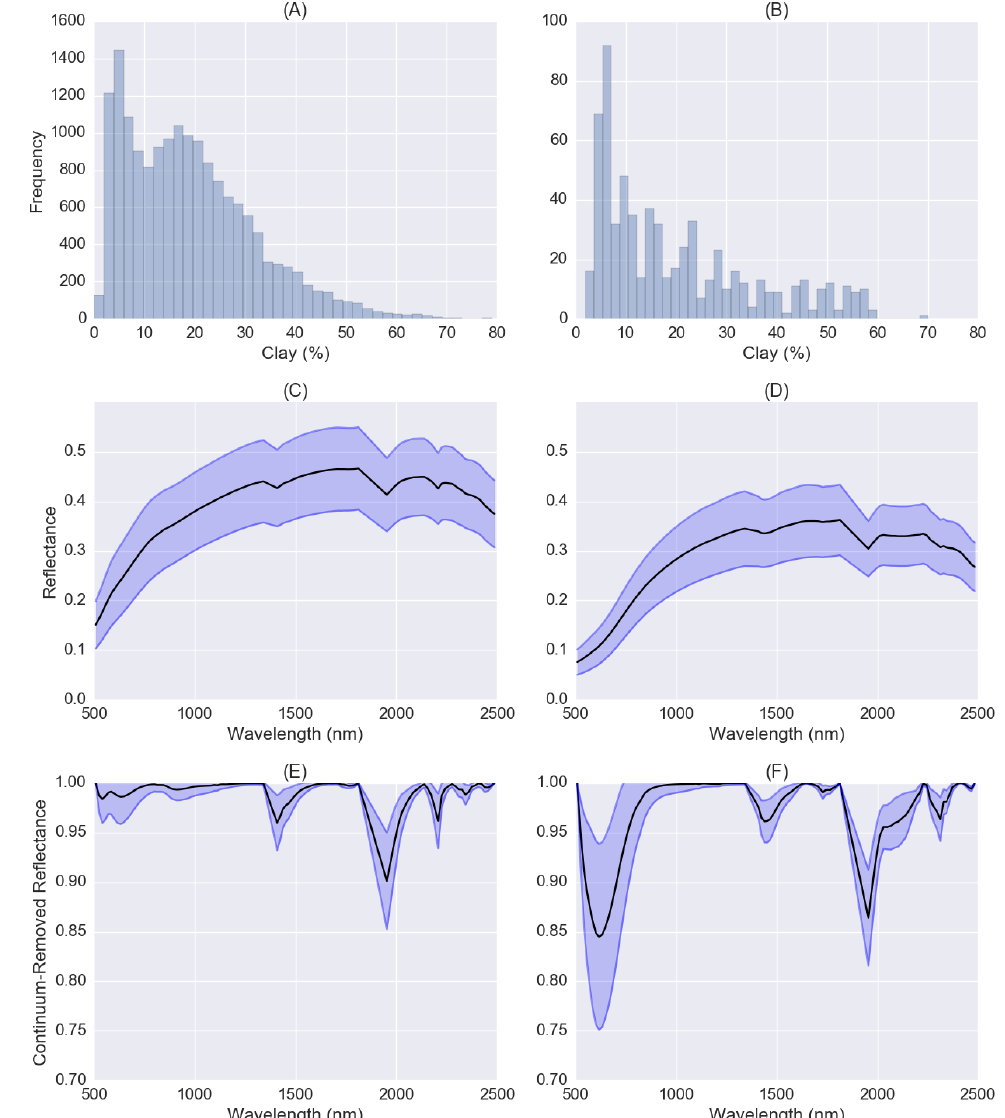
Figure 5. ( A , B ) Histograms of soil clay content distribution of mineral and organic soils; ( C , D ) mean soil reflectance spectra and standard deviations for mineral and organic soils; ( E , F ) mean soil continuum-removal spectra and standard deviations for mineral and organic soils. Values are given in reflectance ( C , D ) and normalised continuum-removal values ( E , F ).